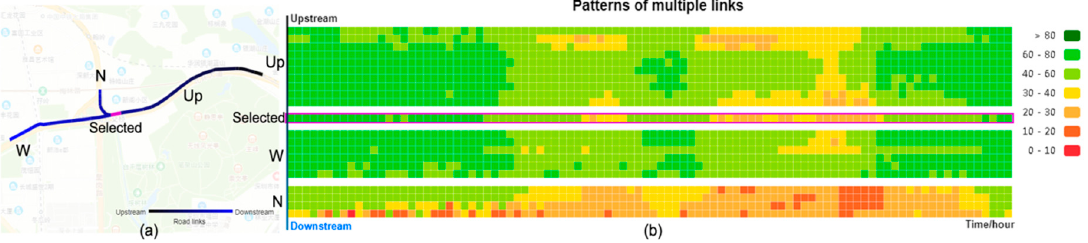
Figure 4. Temporal view of traffic patterns. ( a ) One road link. ( b ) Another road link located on the same road with opposite driving direction.